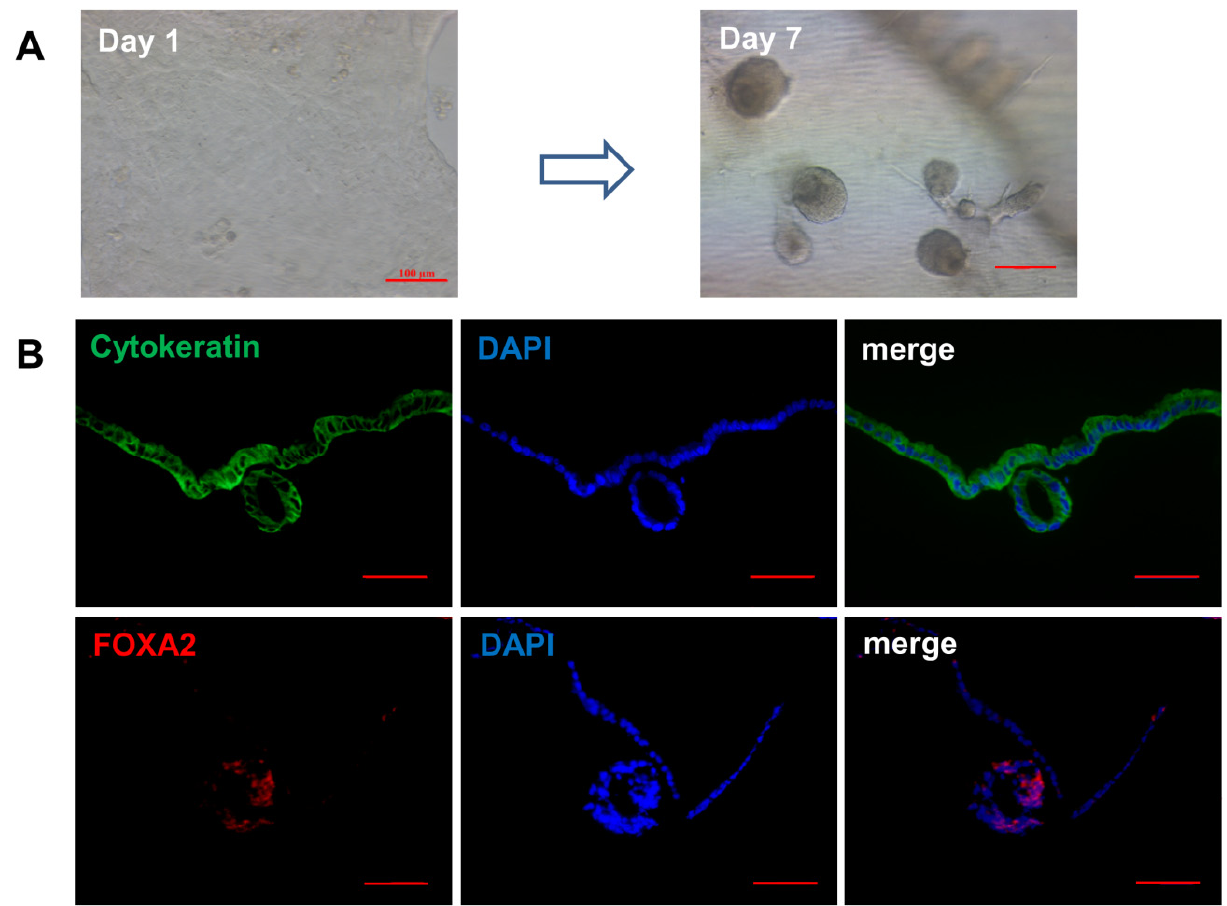
Figure 5. The formation and identification of ovine UGs organoids. ( A ) The formation of UGs organoids in Matrigel. ( B ) The identification of organoids by cytokeratin (green) and FOXA2 (red) immunoreactivity. Bar = 100 μ m.